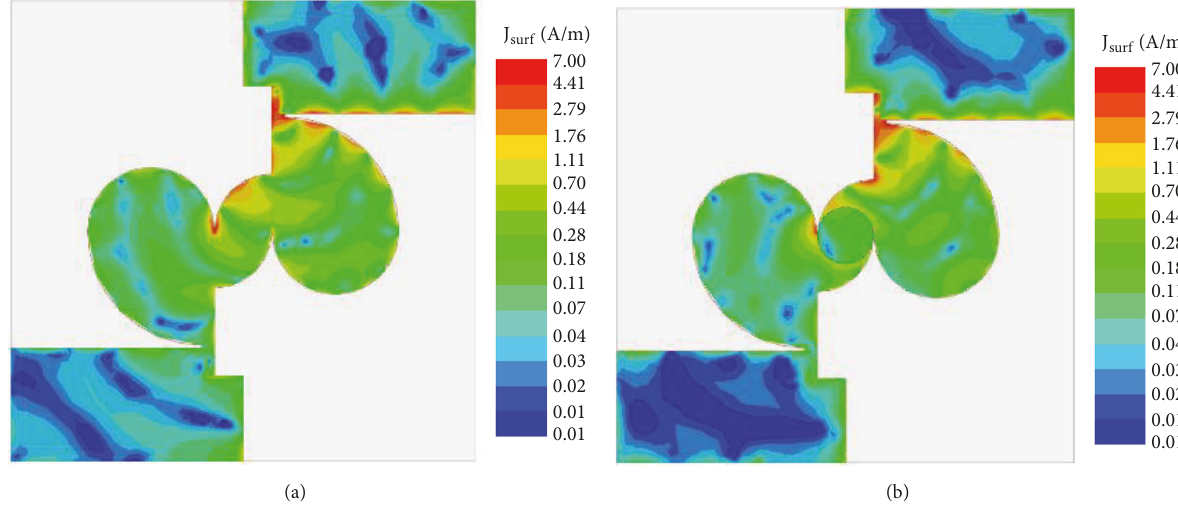
Figure 4: Simulated surface current distribution at 16.5 GHz: (a) Without circular parasitic resonator, (b) with the resonator.